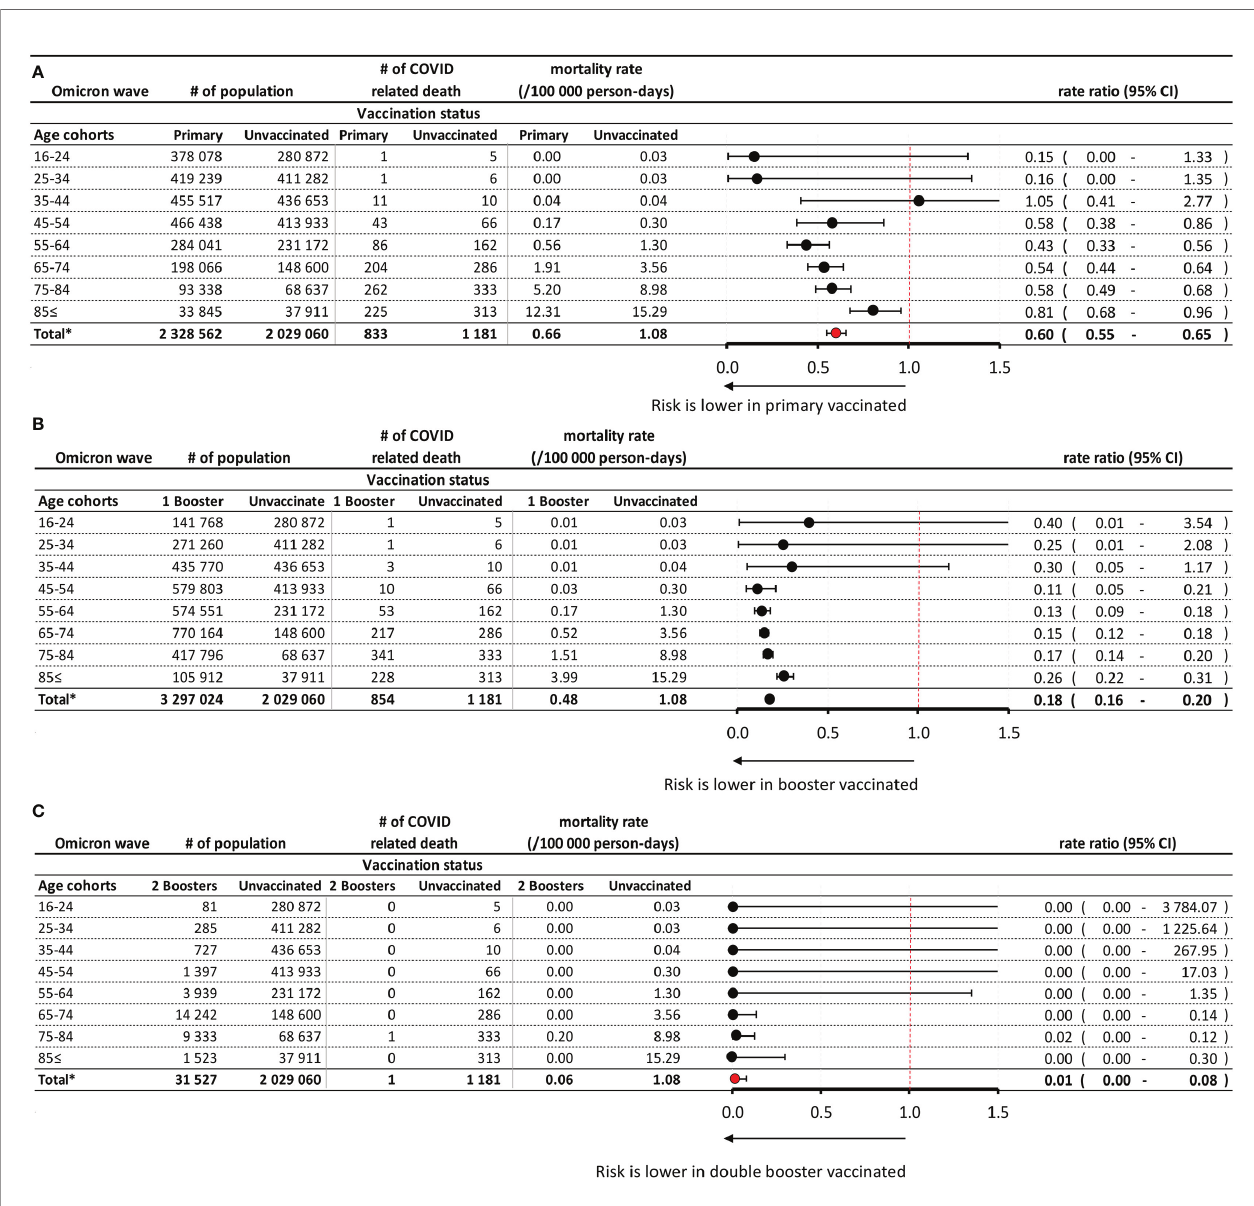
FIGURE 3 | Risk of Covid-19 related mortality during the Omicron wave in the primary immunized vs. unvaccinated control population (A) , in the booster vaccinated vs. unvaccinated control population (B) , and in the double booster vaccinated vs. unvaccinated control population (C) , according to age. *Exact con fi dence intervals for age-speci fi c mortality rate ratios and Mantel-Haenszel pooled mortality rate ratio for the total population adjusted for